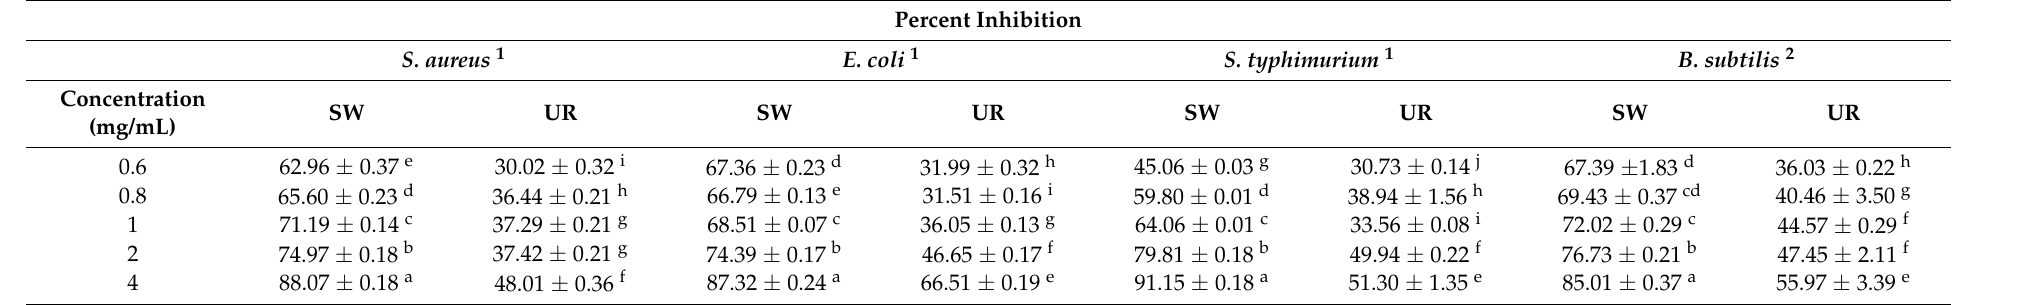
Table 2. Percentage inhibition of S. wightii and U. rigida extracts against selected food pathogens 1 and food spoilage bacteria 2